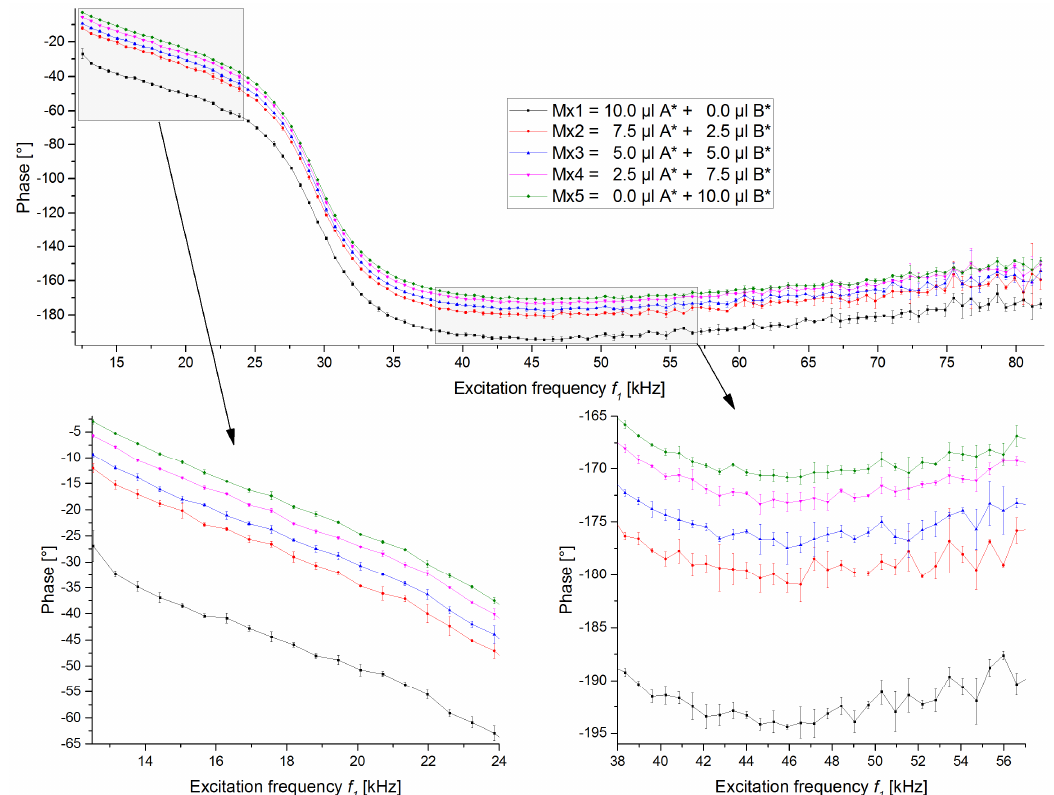
Figure 6. Phase traces of excitation frequency scans using the same beads and bead solution concentrations as in Figure 5/Table 2, except that the bead solution for SynomagD (bead B) is not the original manufacturer stock solution but an already diluted one, to reduce the dominant effect of this bead in the measurement. The mean and standard deviation at each excitation frequency are shown.